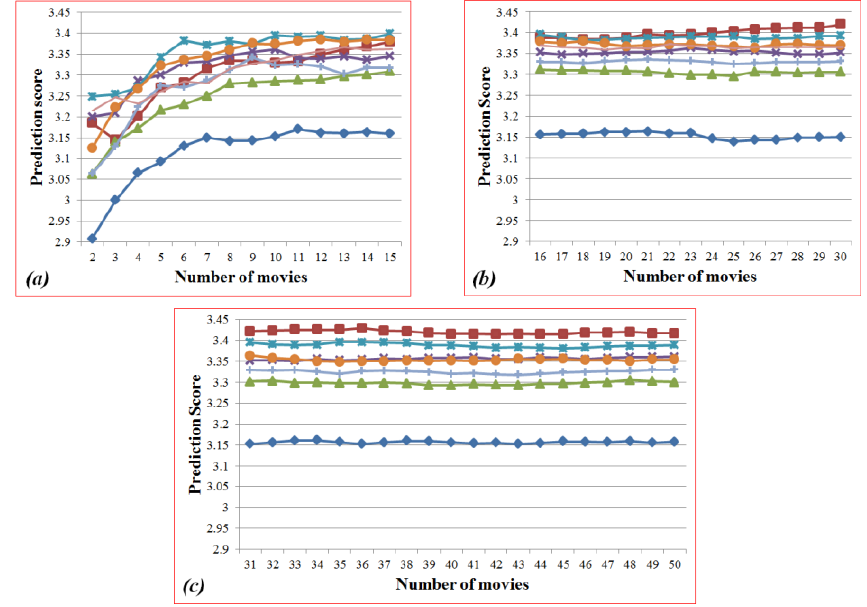
Figure 13. Sub-graphs of Figure 12: ( a ) the ranges from 2 to 15; ( b ) from 16 to 30; ( c ) from 31 to